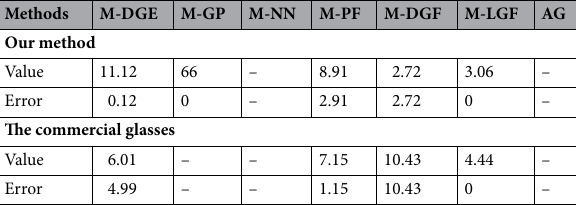
Table 3. GFS of our method and the commercial glasses.